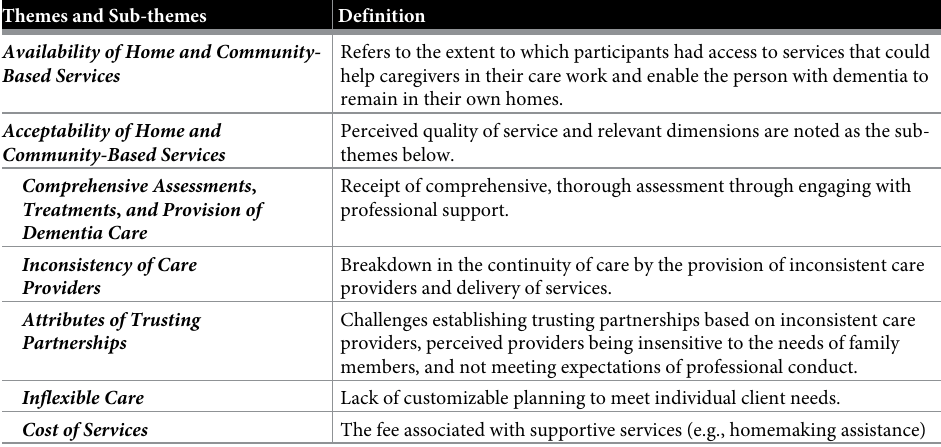
Table 1. Forbes et al, themes, sub-themes and